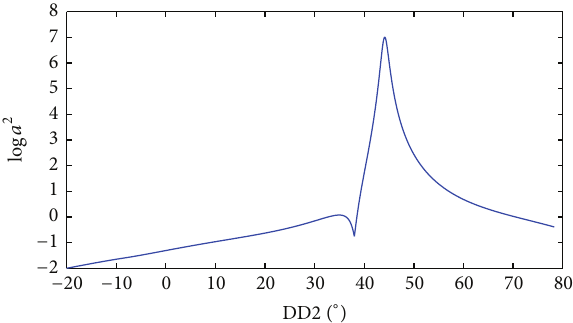
Figure 3: The effective coupling parameter 𝑎 2 along the seam line with DD1 = − 103.3 ∘